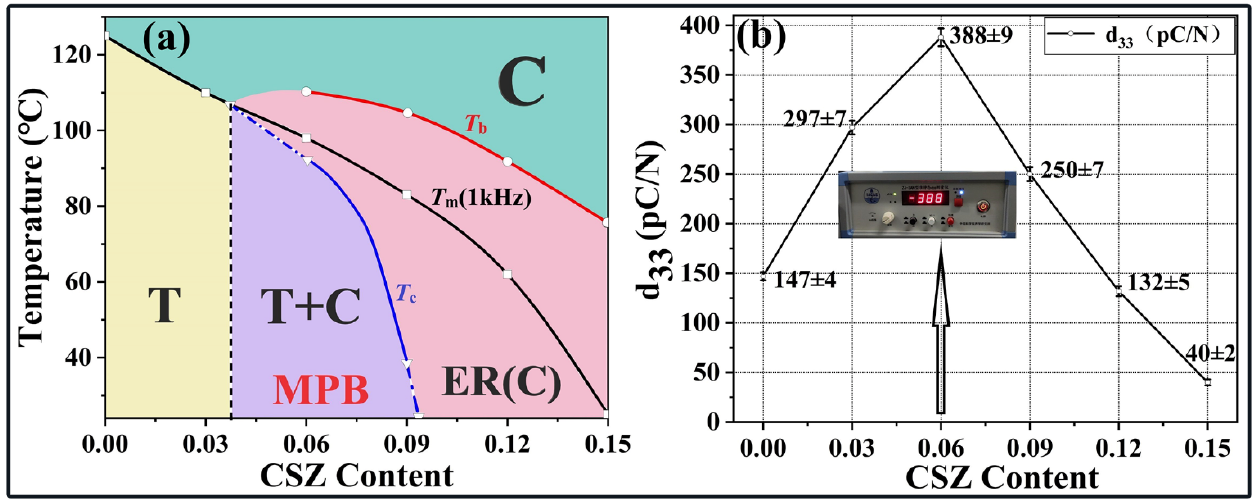
Figure 7. ( a ) phase diagram and ( b ) d 33 values of the (1 − x )BT- x CSZ ceramics as a function of x .